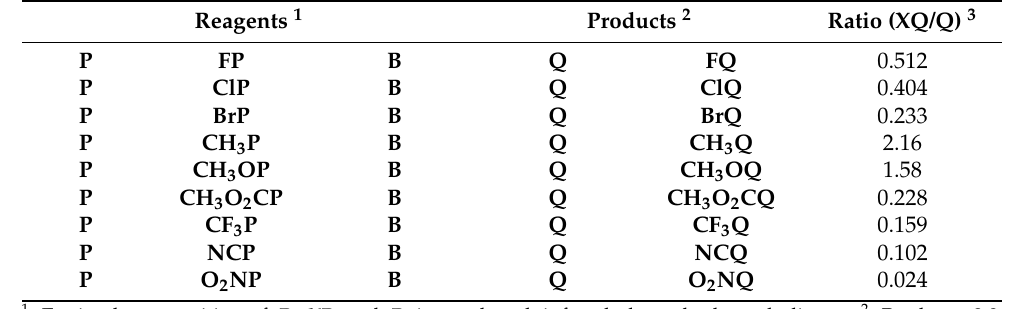
Table 1. Ratio of 2,3-diphenylquinoxaline and 6-substituted-2,3-diphenylquinoxaline formed in competition experiments in the